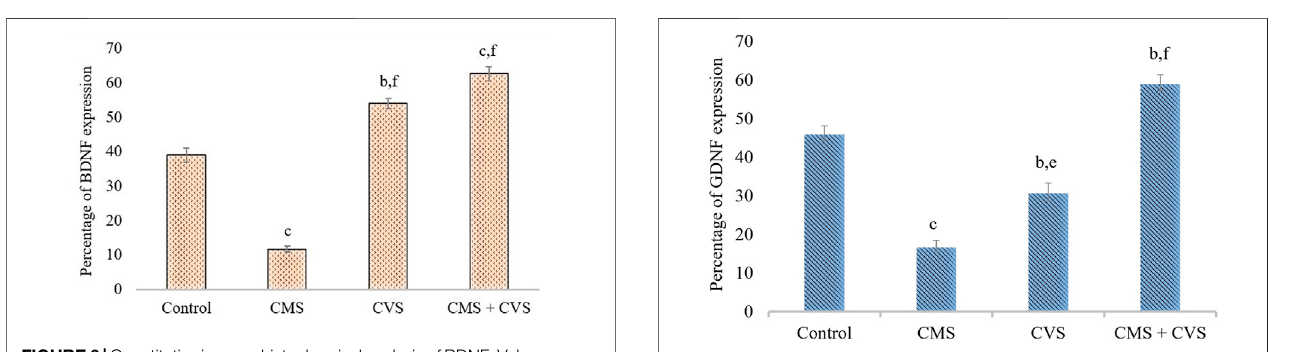
FIGURE6| QuantitativeimmunohistochemicalanalysisofBDNF.Values are expressed as mean ± SEM ( n = 6). b p < 0.01, c p < 0.001 compared with thatofcontrolgroup; f p < 0.001comparedwiththatofstressgroup.(One-way ANOVA followed by Tukey ’ s post hoc test).